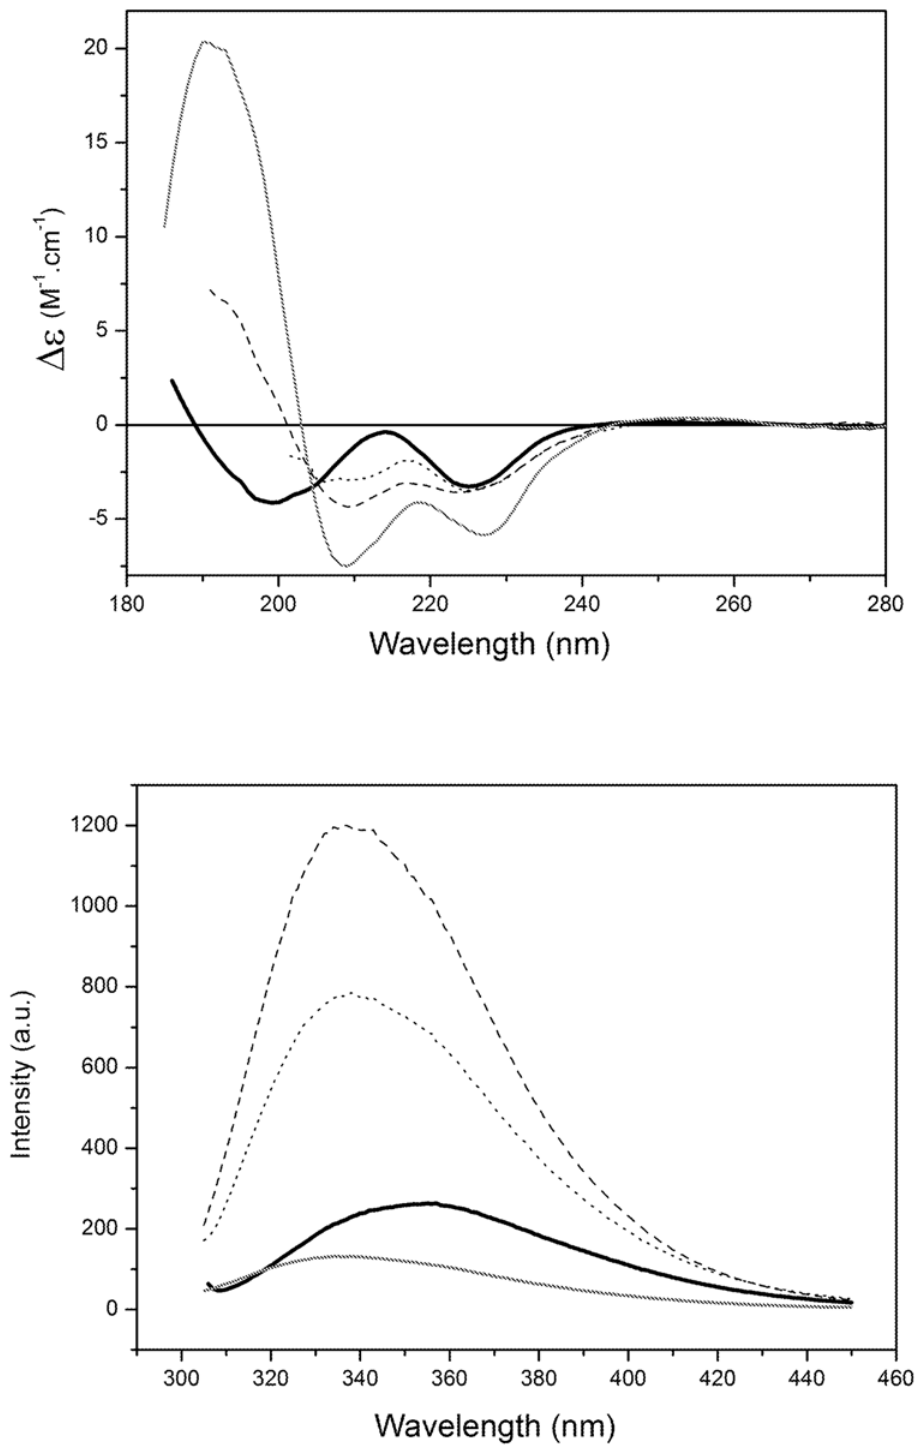
Fig 2. Interactions of the Sit1 peptide with different types of model membranes. a) CD spectroscopy Sit1 in the presence of micelles composed of HPS (dash), CTAB (dot), and SDS (grey), compared with the peptide in aqueous solution (black). b) Emission spectra of Sit1 in aqueous solution (black) and in the presence of HPS (dash), CTAB (dot), and SDS (grey) detergents.